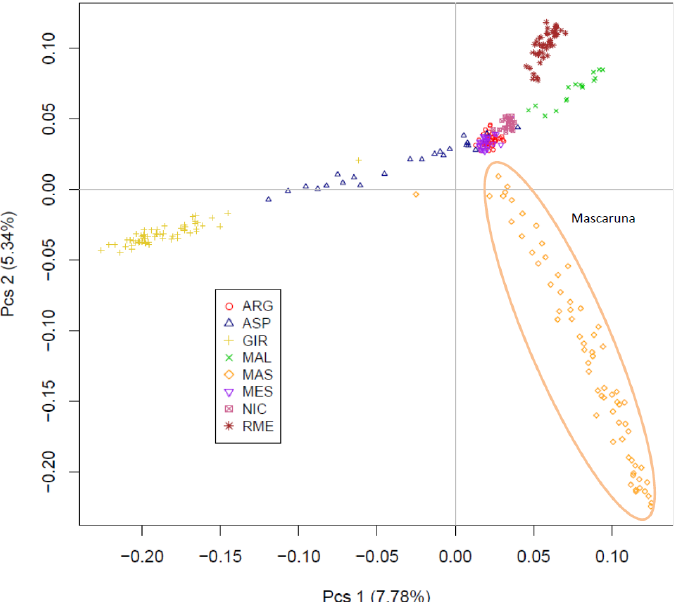
Figure 4. Multidimensional scaling analysis between Mascaruna and the southern goat populations. For full definition of the populations, see Table 1. The pairwise F ST value among all 32 populations ranged from 0.001 (Messinese vs.